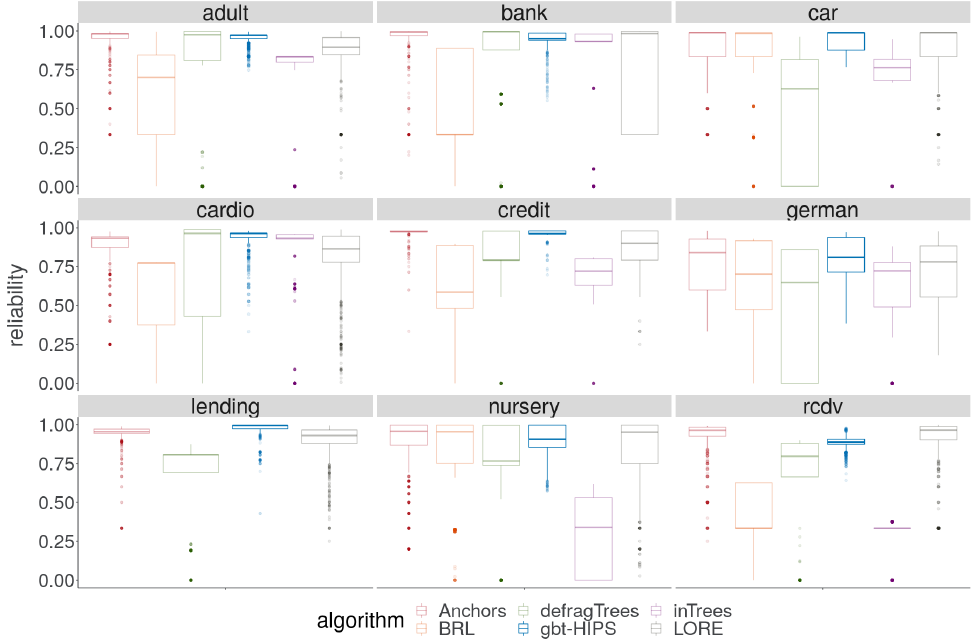
Figure 6. Distribution of reliability for stochastic GBT model explanations.